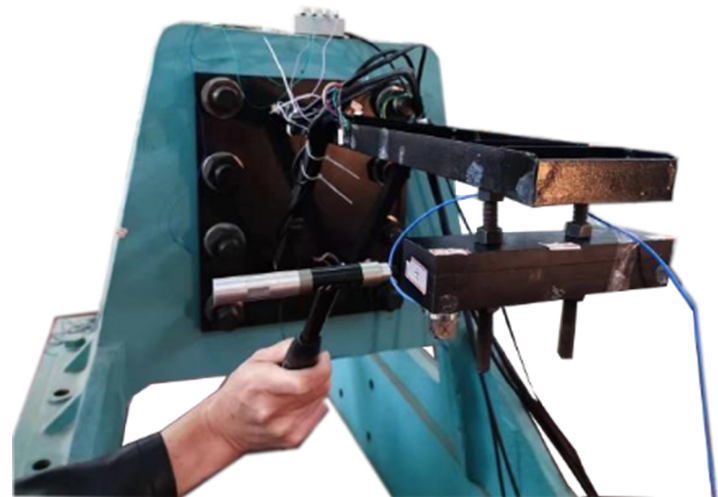
Figure 4. Test of single pylon.